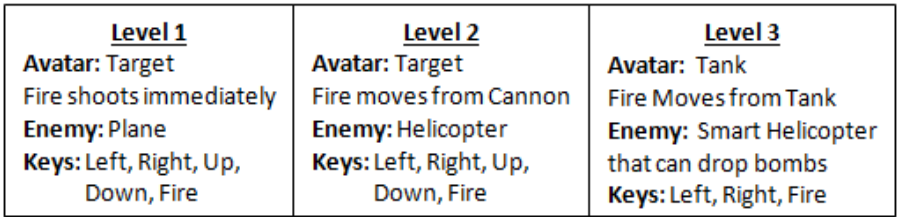
Figure 4. Sample level-based game.